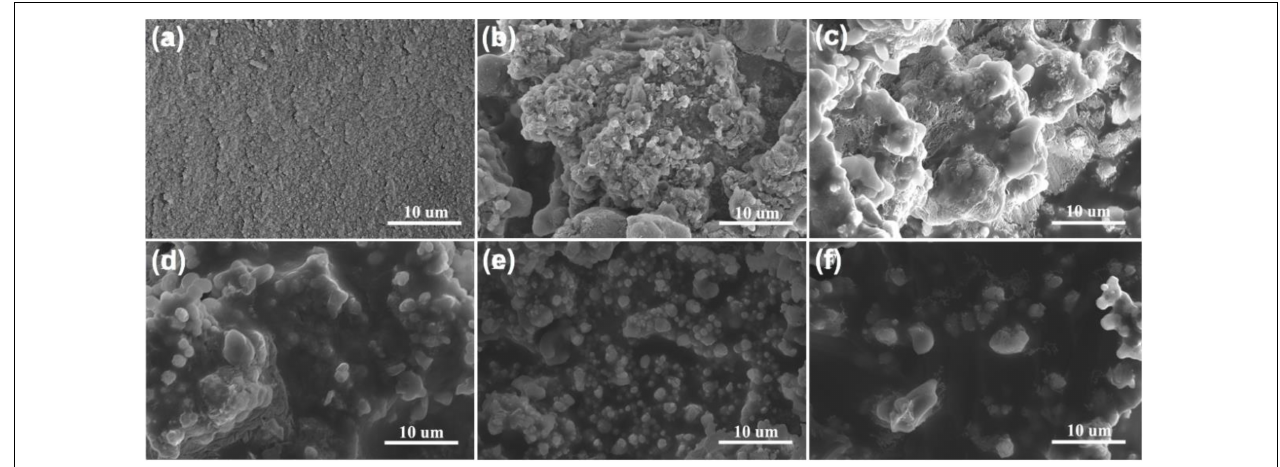
FIGURE 2 | SEM images of pure SiO 2 aerogel (a) , SiO 2 /OPU-1 (b) , SiO 2 /OPU-2 (c) , SiO 2 /OPU-3 (d) , SiO 2 /OPU-4 (e) , and SiO 2 /OPU-5 (f)